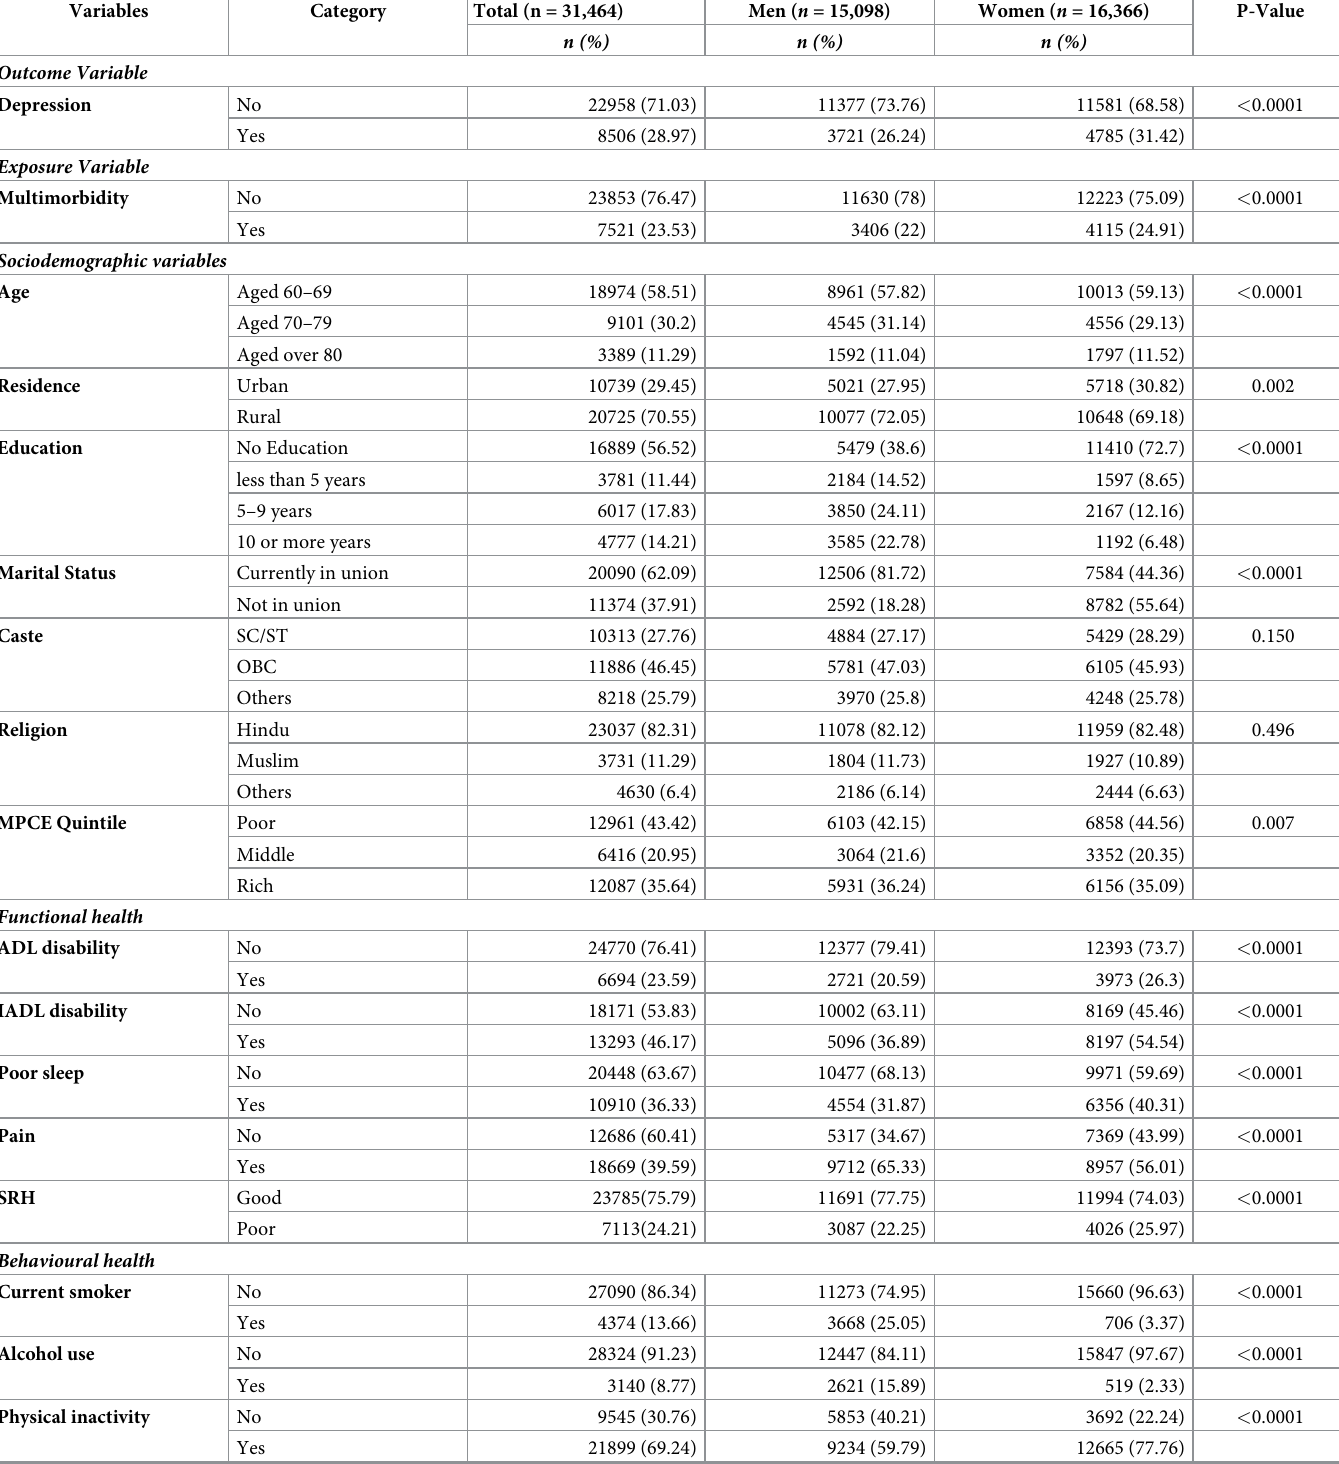
Table 1. Socio-demographic and health-related profile of the study sample by gender, LASI